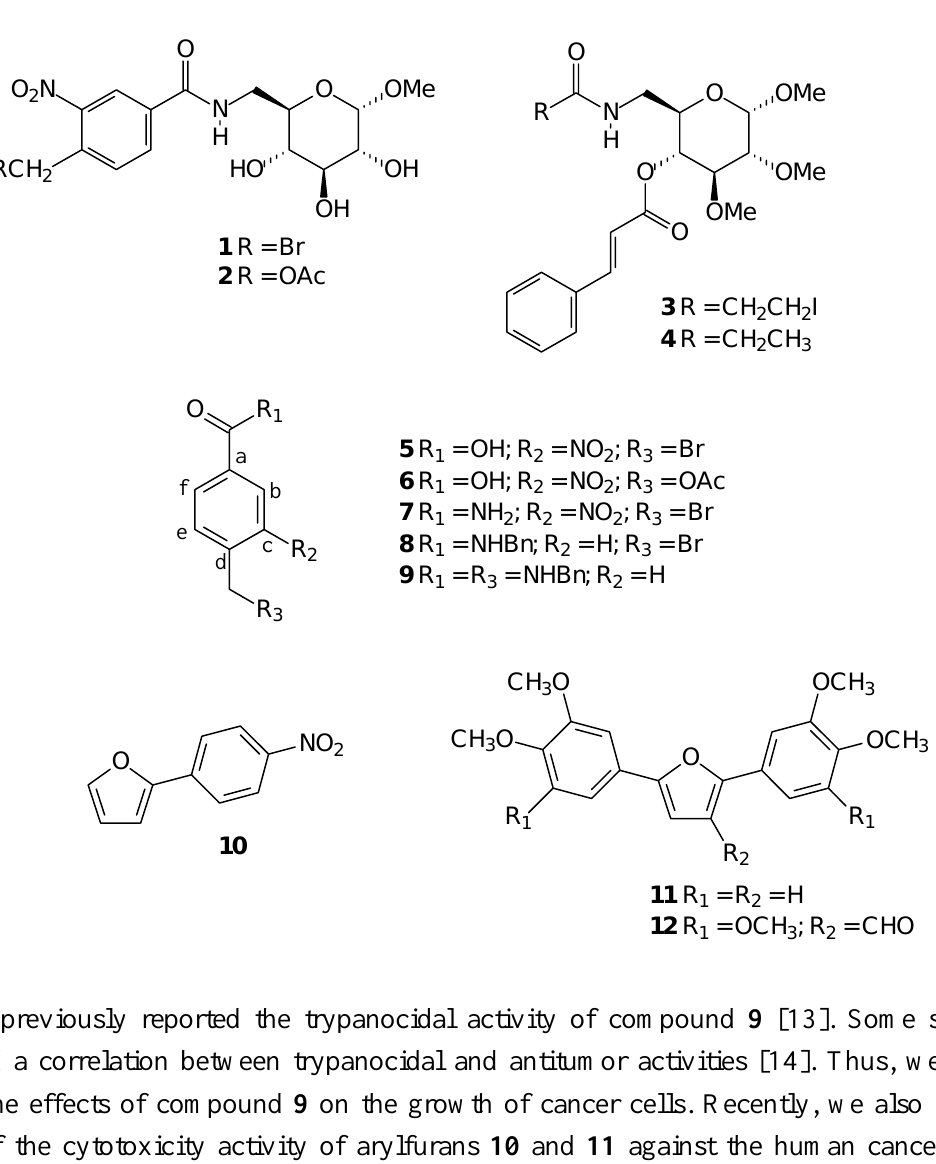
Figure 1. Chemical structures of compounds tested as cytotoxic